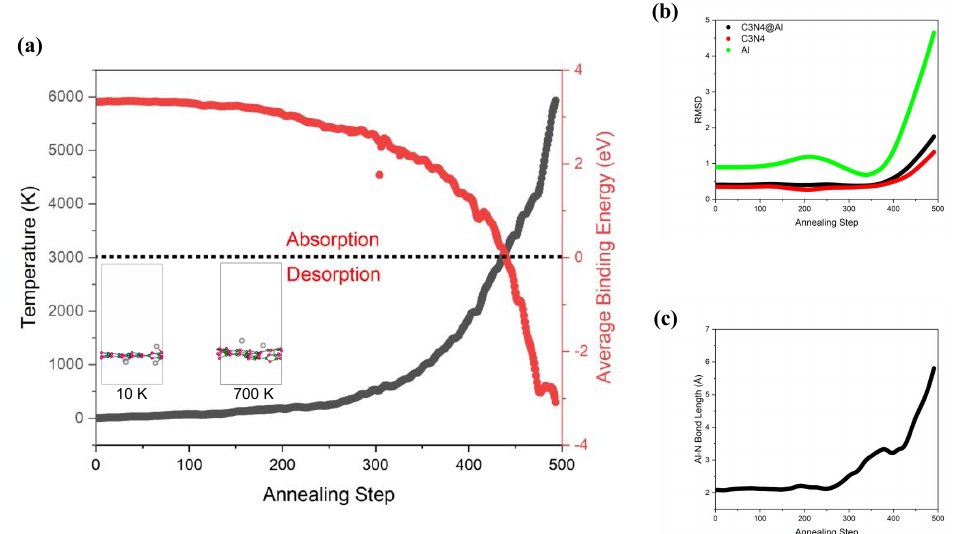
Figure 7. DFT MD simulations of the Al − decorated g-C ( b ) RMSD (root mean square deviation) and ( c ) the change of Al-N bond length. The system is heated from 10 K to 1200 K, and the time step is set to 1.0 fs.